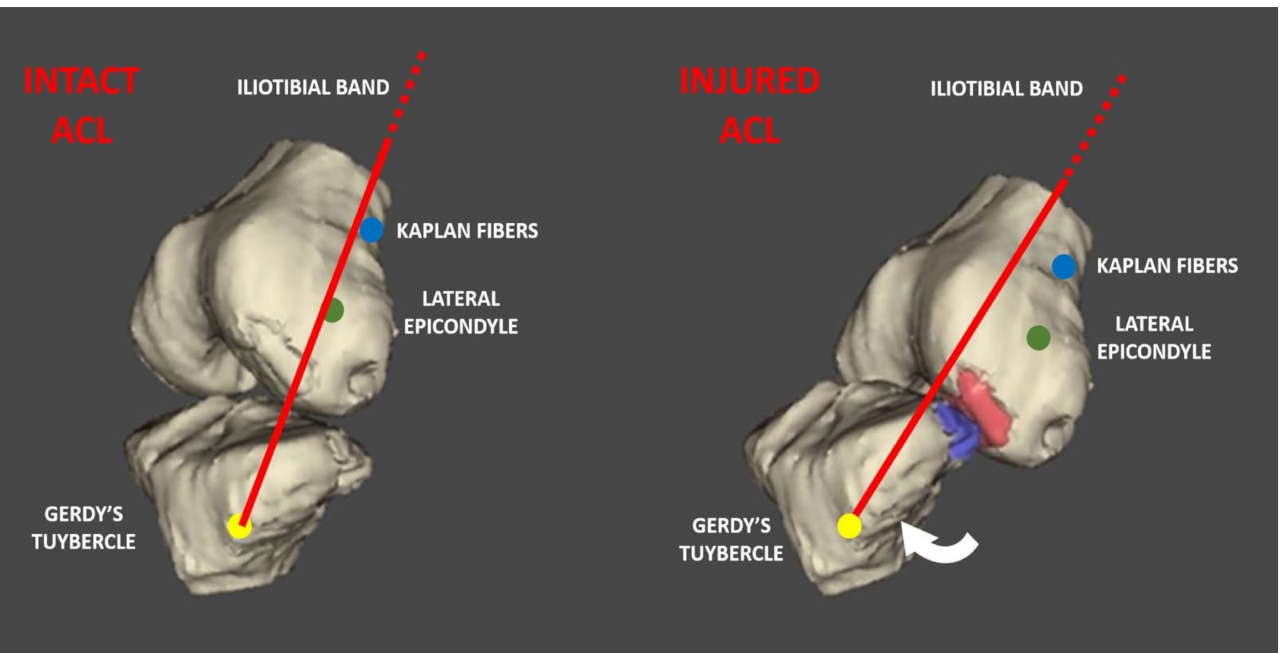
Figure 1. This 3D rendering shows the relationships between anatomical landmarks of the knee and the direction of the iliotibial band with an intact ACL and injured